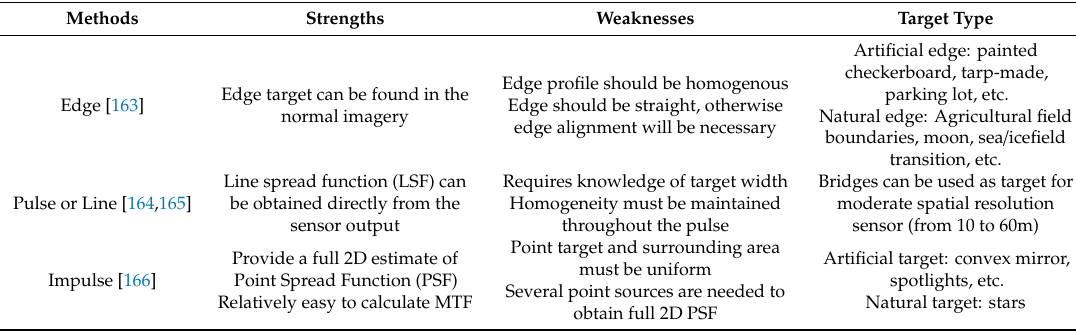
Table 5. MTF estimation